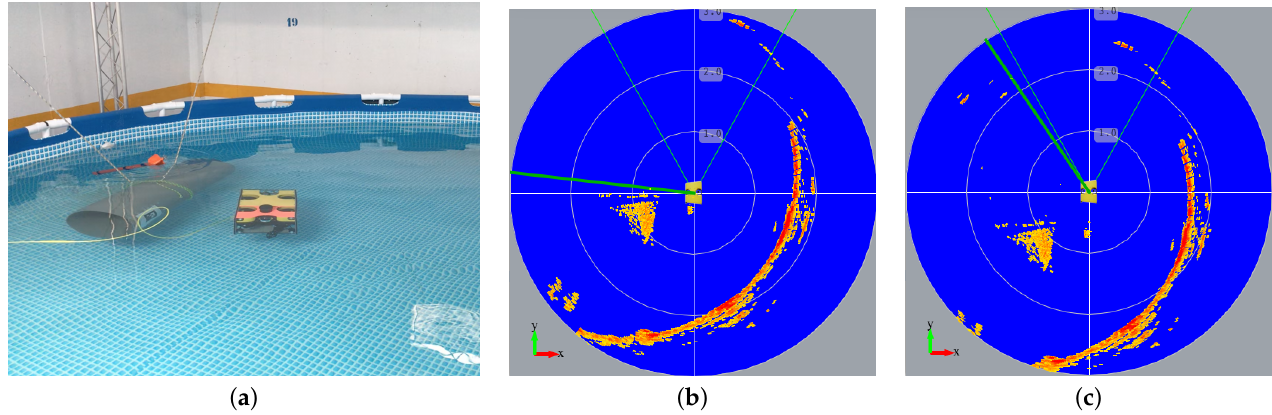
Figure 5. ( a ) Underwater vehicle with mechanical scanning sonar at the top, ( b ) local buffer of data received from the sensor, and ( c ) local buffer after the rotation and displacement of the underwater